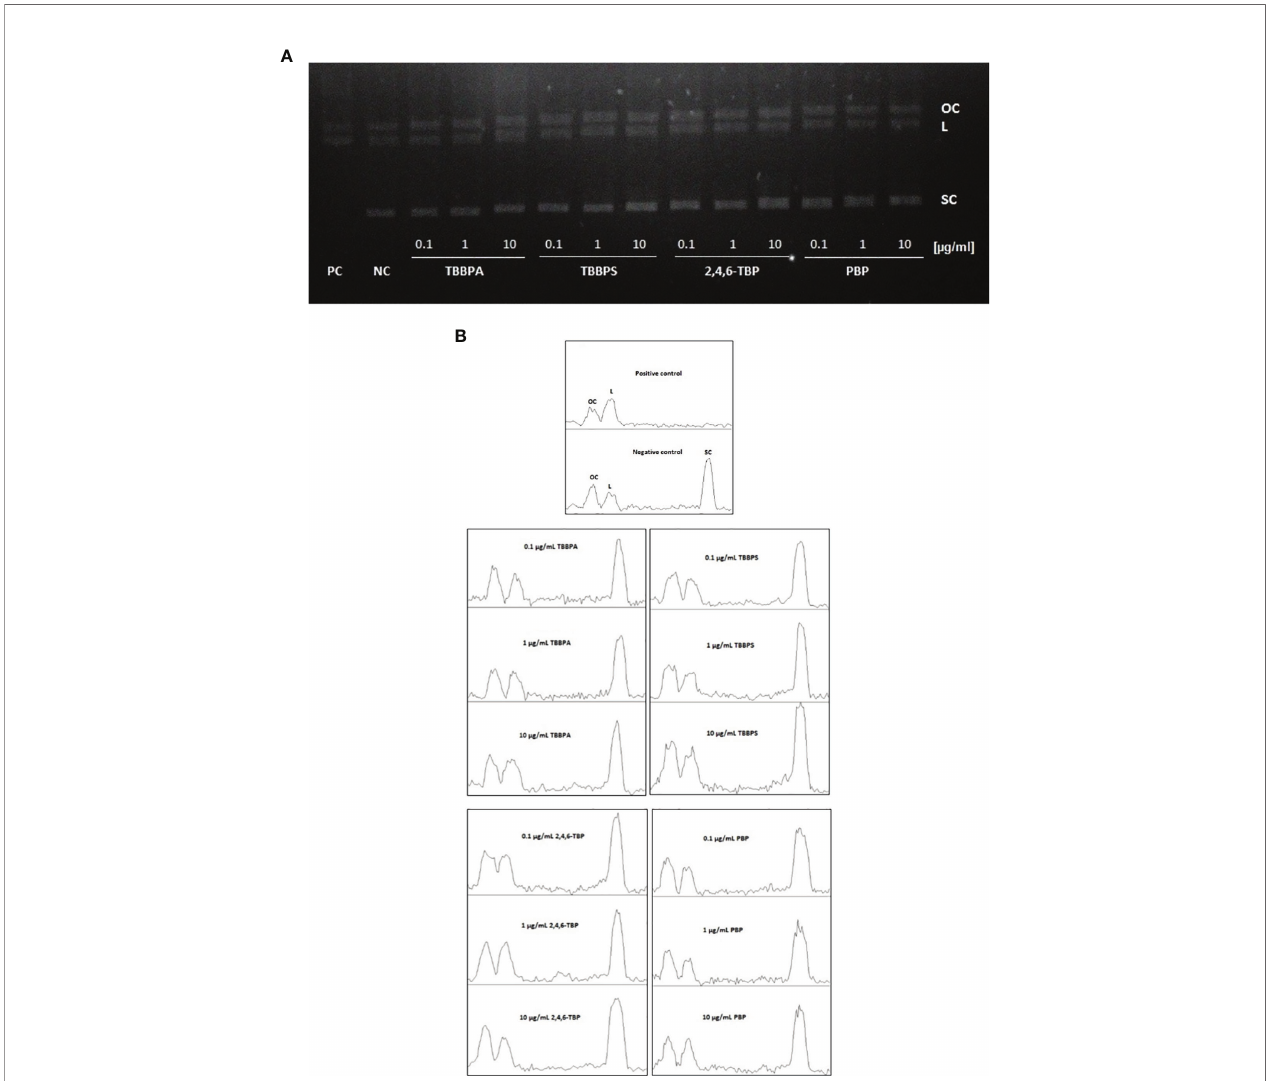
FIGURE 6 | DNA adducts formation. Plasmid relaxation assay. (A) Plasmid DNA pUC19 was resolved on a 1% agarose gel, stained with ethidium bromide and visualized in UV light; line 1 - positive control (PC) (the plasmid was exposed to hydroxyl radicals generated in Fenton reaction), line 2 - negative control (NC) (pUC19 plasmid), lines 3-14 - pUC19 plasmid incubated with TBBPA, TBBPS, 2,4,6-TBP and PBP at 0.1 µg/mL, 1 µg/mL and 10 µg/mL. Structural differences between supercoiled (SC), open circular (OC) and linear (L) forms of the plasmid accounted for their different electrophoretic mobility. (B) Densitometric analysis of agarose gel was presented below the gel image. Open circular (OC) (as a consequence of DNA single strand breaks), linear (L) (as a consequence of DNA double strand-breaks) and supercoiled (SC) (undamaged DNA) forms of DNA plasmid are presented as peaks. Densitometric analysis was performed with the Gel Analyzer tool of